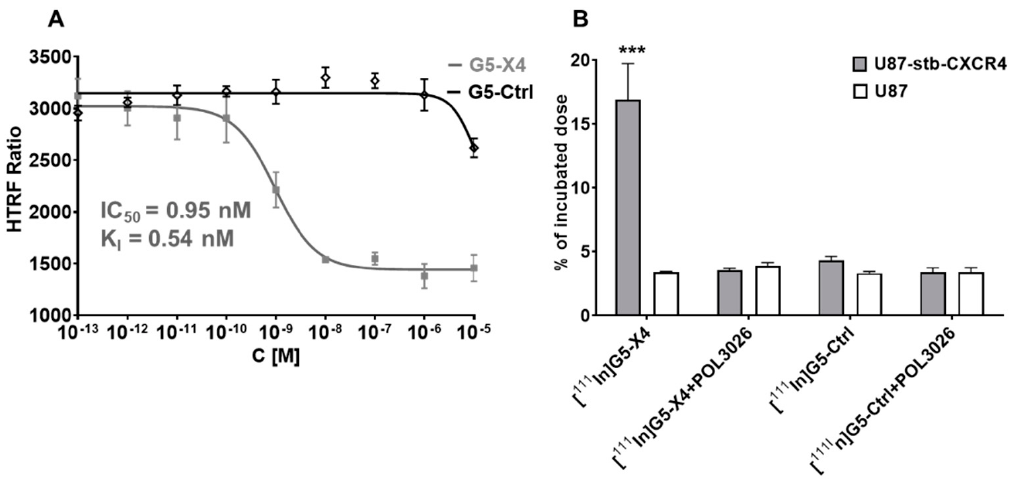
Figure 2. In vitro evaluation G5-X4 and G5-Ctrl. ( A ) Assessment of CXCR4 affinity: CHO-K1-stb- CXCR4-Lumi4-Tb cells were incubated with CXCL12-Red and increasing concentration of either G5-X4 or G5-Ctrl at RT for 2 h followed by FRET analysis. ( B ) In vitro binding: U87-stb-CXCR4 or U87 cells were incubated with [ 111 In]G5-X4 or [ 111 In]G5-Ctrl in the presence or absence of POL3026 for 1 h at RT, washed and analyzed on a gamma counter. Both assays indicate high in vitro CXCR4 specificity of G5-X4 dendrimer. *** p < 0.01